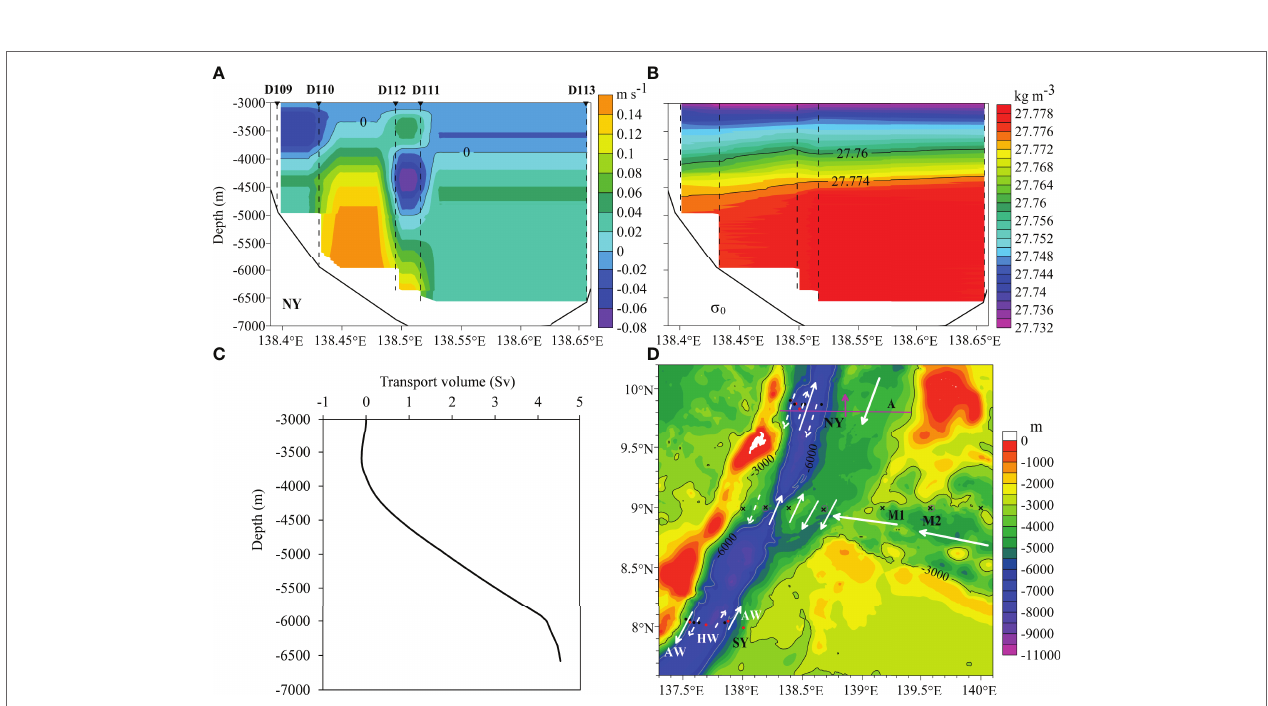
FIGURE 2 | (A) Meridional geostrophic flows at section NY in northern Yap Trench. Positive and negative values correspond to northward and southward currents, respectively. Submersible Jiaolong dives at stations D109–D113 are denoted by dashed lines. (B) Potential density σ 0 at NY. (C) Meridional geostrophic transport volume (from the reference level to a depth) at NY, the northward is positive. (D) Patterns of water transportation at sections NY, SY, M1, and M2 (black dots: Jiaolong diving; red dots: ship-CTD). AW, abyssal water; HW, hadal water. At NY, dashed arrow line: upper water flow; solid line: deeper water flow. The purple line is section A at the northern trench (Liu et al., 2018). M1 (black crosses) and M2 (purple circles) are two observation sections of WOD18. At the sill, the dashed arrow line denotes upper